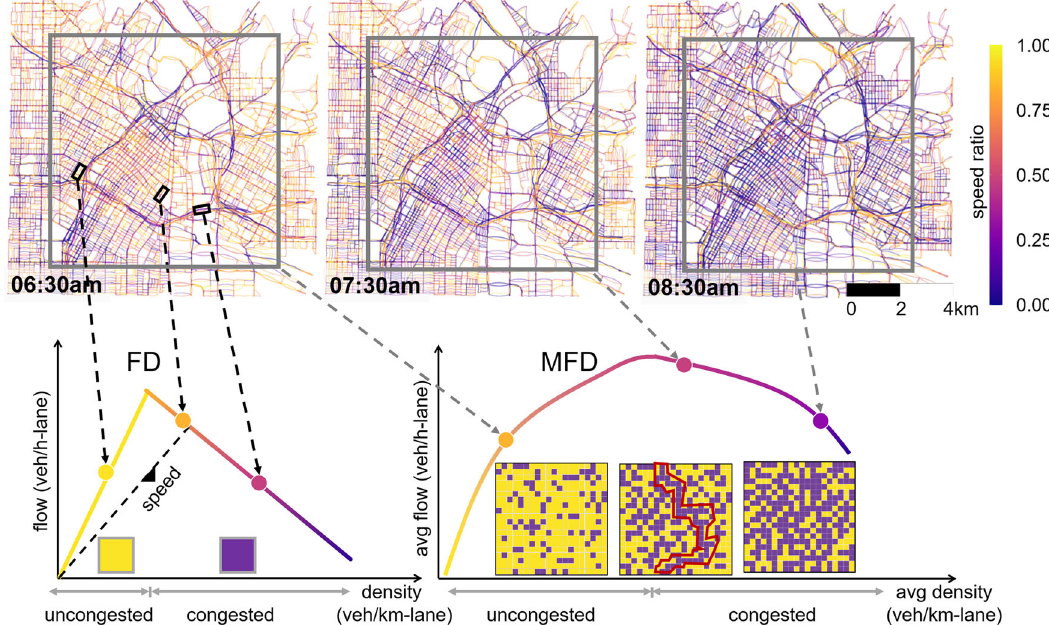
Fig. 1 Examples of link and network level perspectives compared. The fi gure shows traf fi c conditions (measured in speed ratio) at 06:30, 07:30, and 08:30 in Downtown Los Angeles, respectively. The speed ratios are obtained by dividing traf fi c speed by the speed limit. Traf fi c fl ow on a single link is described by a fundamental diagram (FD). Here, we show a triangular version thereof, where we identify two states: uncongested (increasing slope above the yellow box) and congested (decreasing slope above the purple box). At the network level, the macroscopic fundamental diagram (MFD) describes the traf fi c dynamics for urban road networks. We link the two perspectives using percolation represented by squares (sites) of an in fi nite lattice. Each square in the lattice has a certain probability p of being congested (purple) and 1 − p of being uncongested (yellow). This is analogous to a traf fi c network, where each link is either uncongested or congested as de fi ned by a fundamental diagram. Percolation models the likelihood of fi nding a path from the top to the bottom of the lattice via congested (purple) sites based on the value of p . An example of such a path is marked in red in the lattice in the